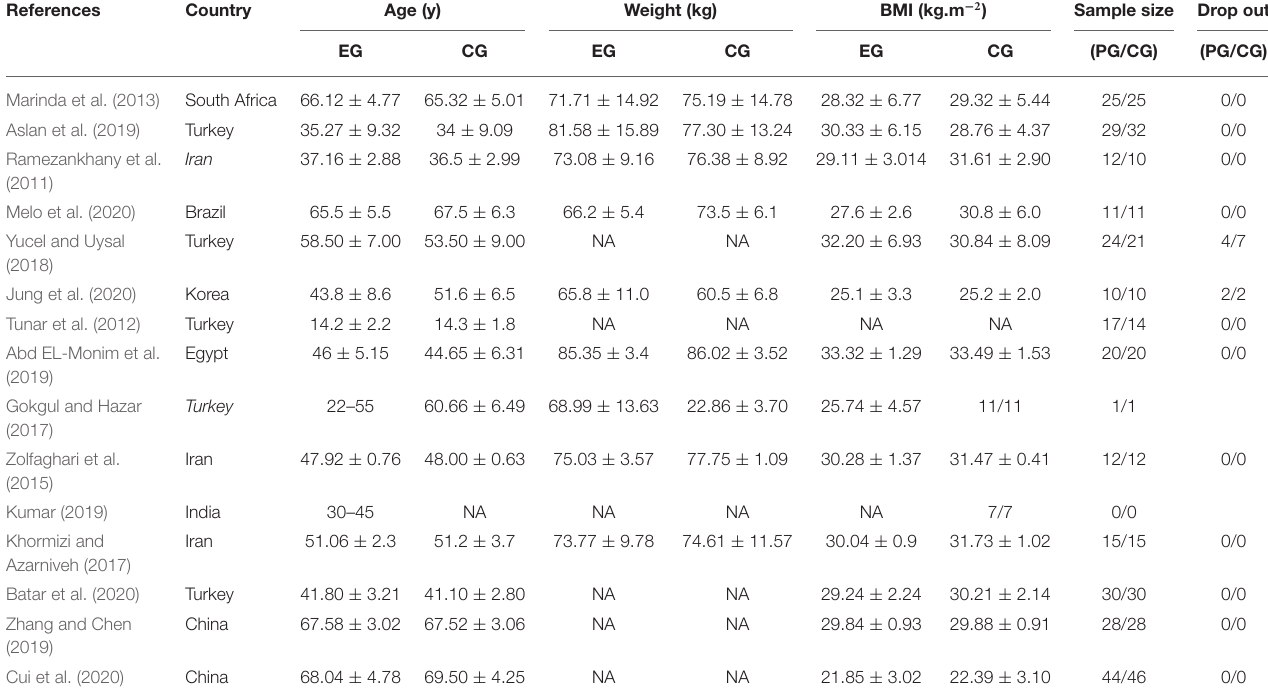
TABLE 1 | Characteristics of the included